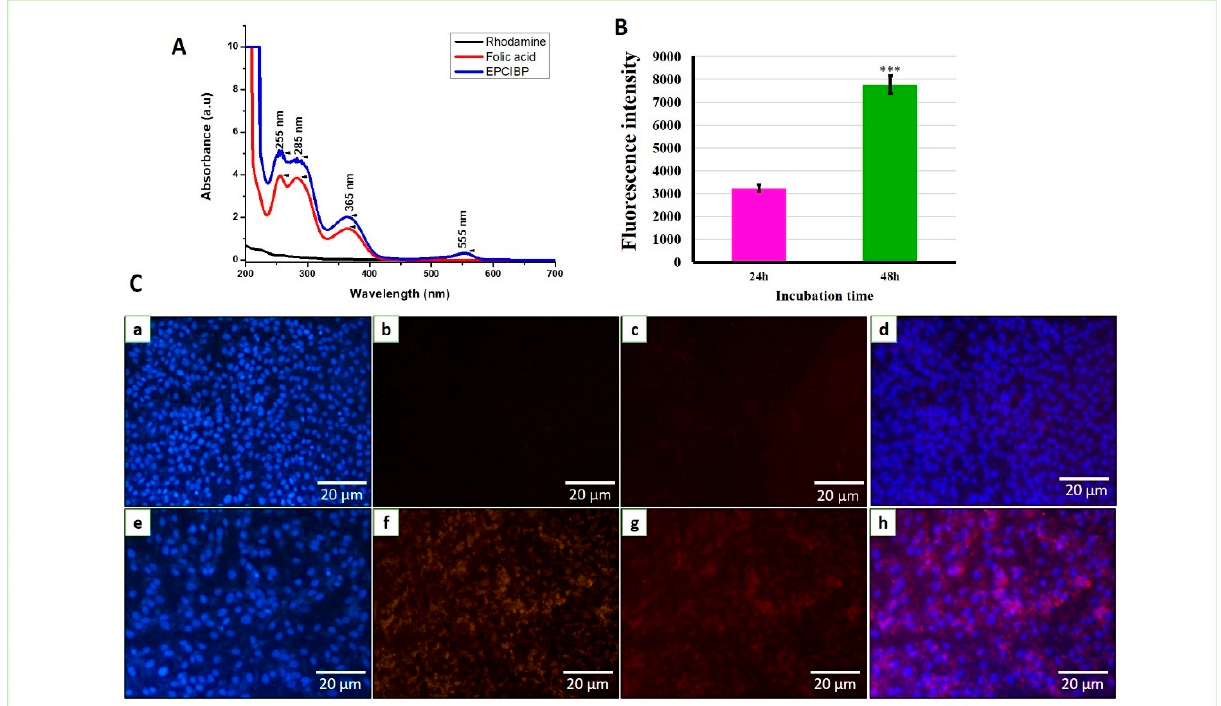
Figure 5. UV-visible results for R6G conjugated to EPCIBP ( A ). Fluorescence image of EPCIBP-conjugated R6G ( B ). Quantification analysis of fluorescence intensity using R6G-labeled nanoparticles under fluorescence microscopy over 24 h with *** p < 0.0001. ( C ). Fluorescence images demonstrate cellular internalization of EPCIBP (without FA) conjugated R6G in A549 cells; ( a ) DAPI stain to show nuclear morphology (blue color). ( b ) FITC channel. ( c ) TRIC channel of R6G (red color). ( d ) Merged images between the FITC channel and TRIC channel produced using the Image J program. Fluorescence images demonstrate cellular internalization of EPCIBP (with FA) conjugated R6G in A549. ( e ) DAPI stain to show nuclear morphology. ( f ) FITC channel. ( g ) TRIC channel of R6G. ( h ) Merged image between the FITC channel and TRIC channel produced using the Image j program.